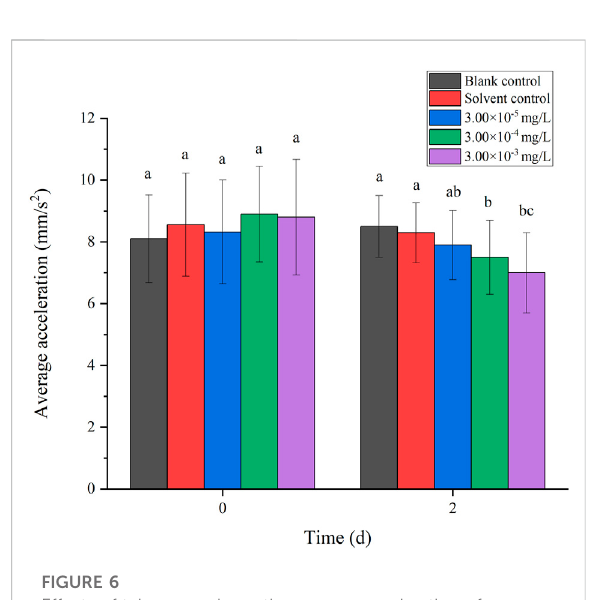
FIGURE 6 Effects of tebuconazole on the average acceleration of zebra fi sh larvae